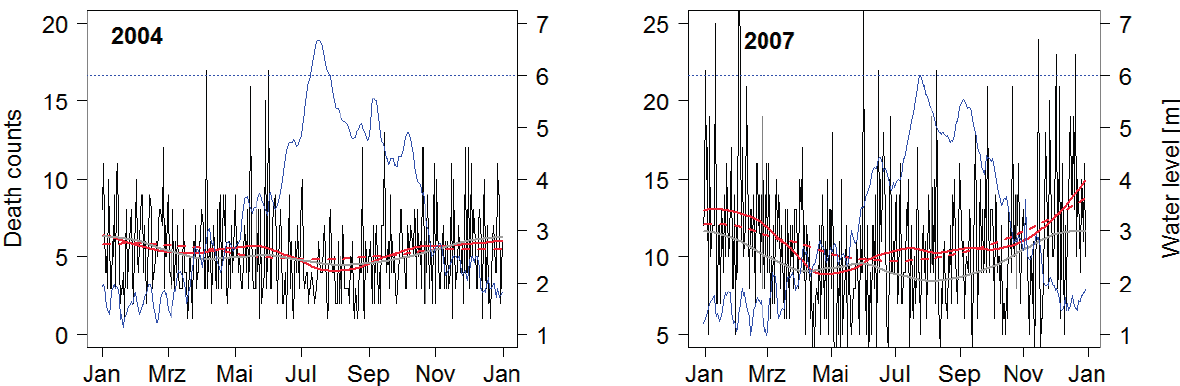
Figure 6. Time series plots of water level in Dhaka ( blue ) and daily deaths in flooded zilas in 2004 and 2007 ( black ). Red solid line displays loess smoothed values using an α of 0.1, the dashed red lines displays loess smoothed values using an α of 0.25. The grey line represents the average mortality from 2003 to